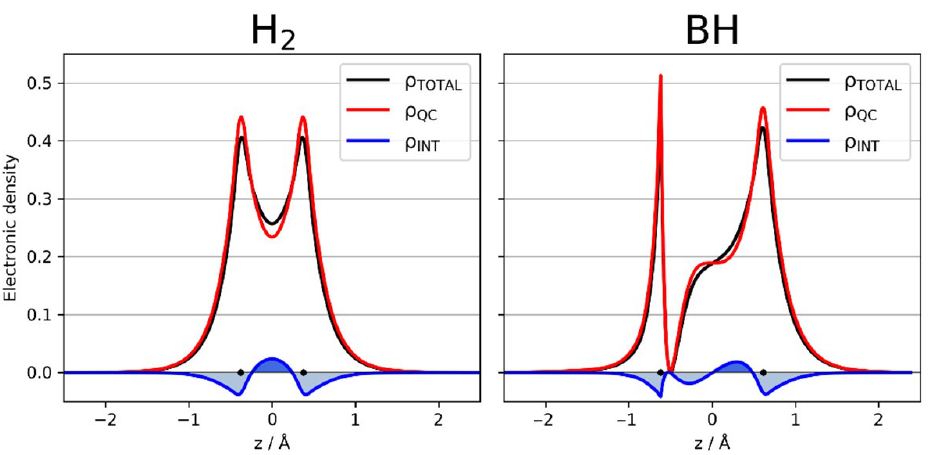
Figure 1. Quasi-classical (red curves), interference (blue curves) and total electronic density (black curves) for a homo (H-H) and a heteronuclear bond (B-H), at the respective equilibrium internuclear distances. The dots ( • ) indicate the position of the nuclei.